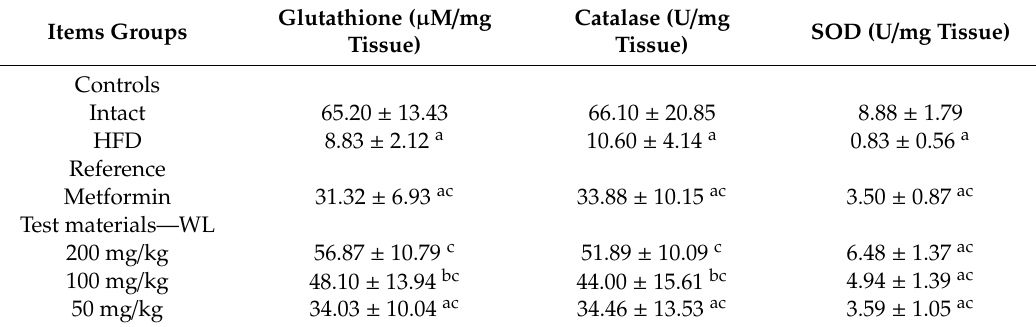
Table 14. Changes in the antioxidant defense systems in NFD or HFD supplied mice. Items